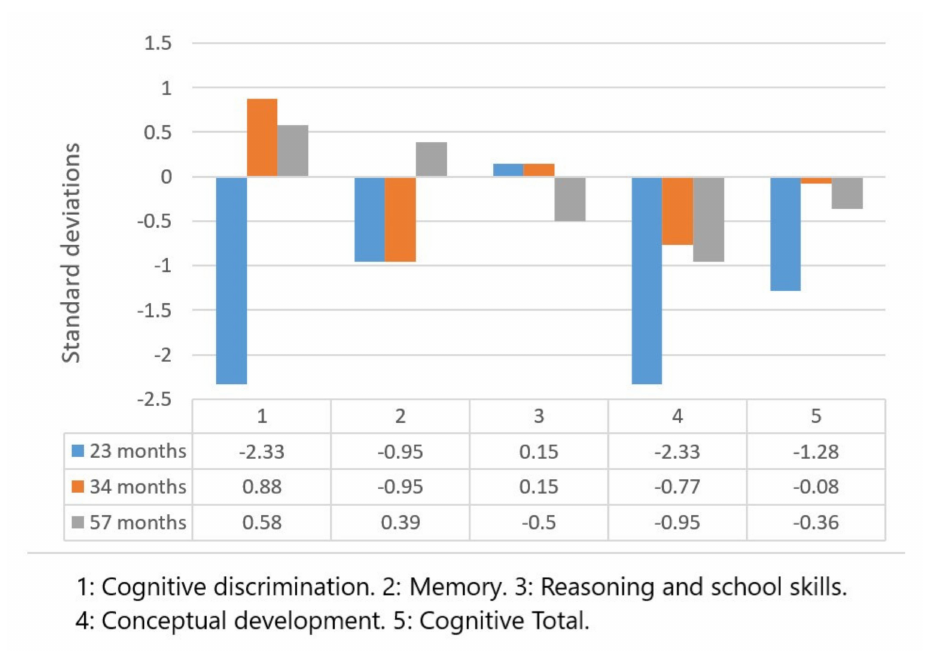
Figure 1. Cognitive scale scores on the Battelle Developmental Inventory.